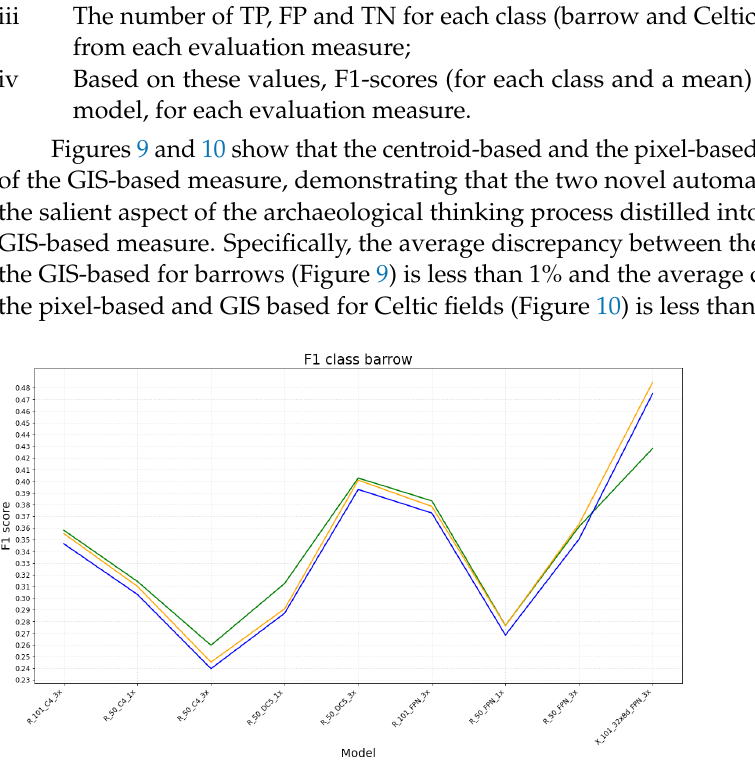
Figure 9. An experimental evaluation of the discrepancy between the centroid-based, in orange ( (cid:110) ), the pixel-based measure in green ( (cid:110) ), and the semi-automatic GIS-based measure, in blue ( (cid:110) ), employed to assess the detection performance of nine different object detection networks in identi- fying barrows. The centroid-based measure has the same trend of the GIS-based one. The average discrepancy between the two curves (orange and blue) is less than 1%.